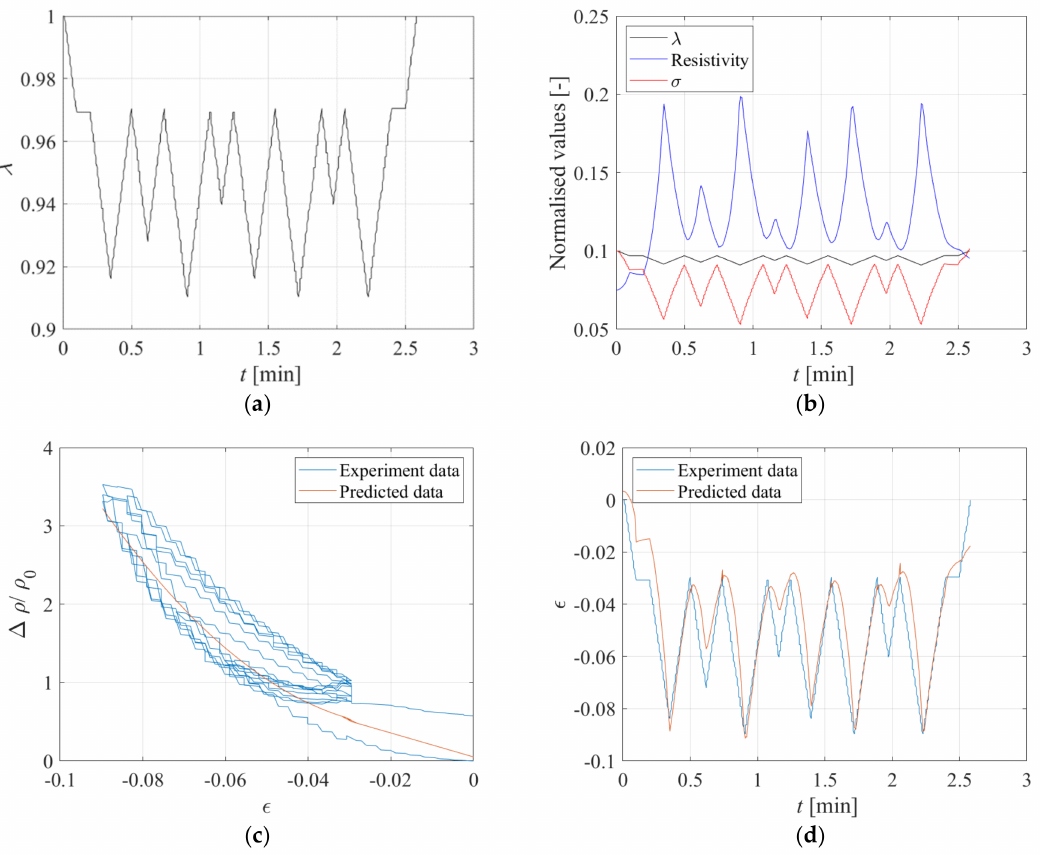
Figure 32. ( a ) Input random, ( b ) Time history of normalised displacement, stress, and electrical resis- tance under the displacement input of Figure 32a. Comparison between experiment and predicted data: ( c ) Variation of resistivity vs. strain, and ( d ) Strain vs. time.